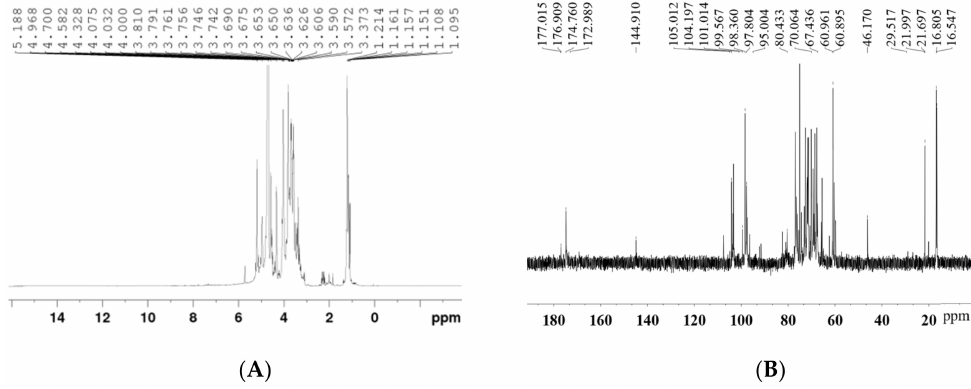
Figure 3. The 1 H ( A ) and 13 C ( B ) NMR spectra of